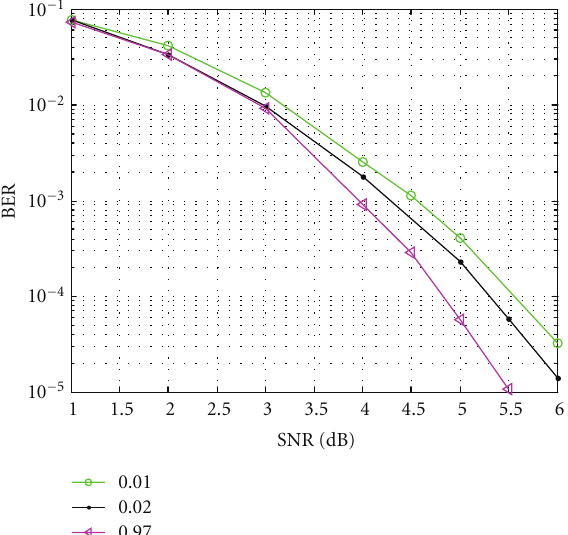
Figure 9: Comparison between di ff erent crossover operators in